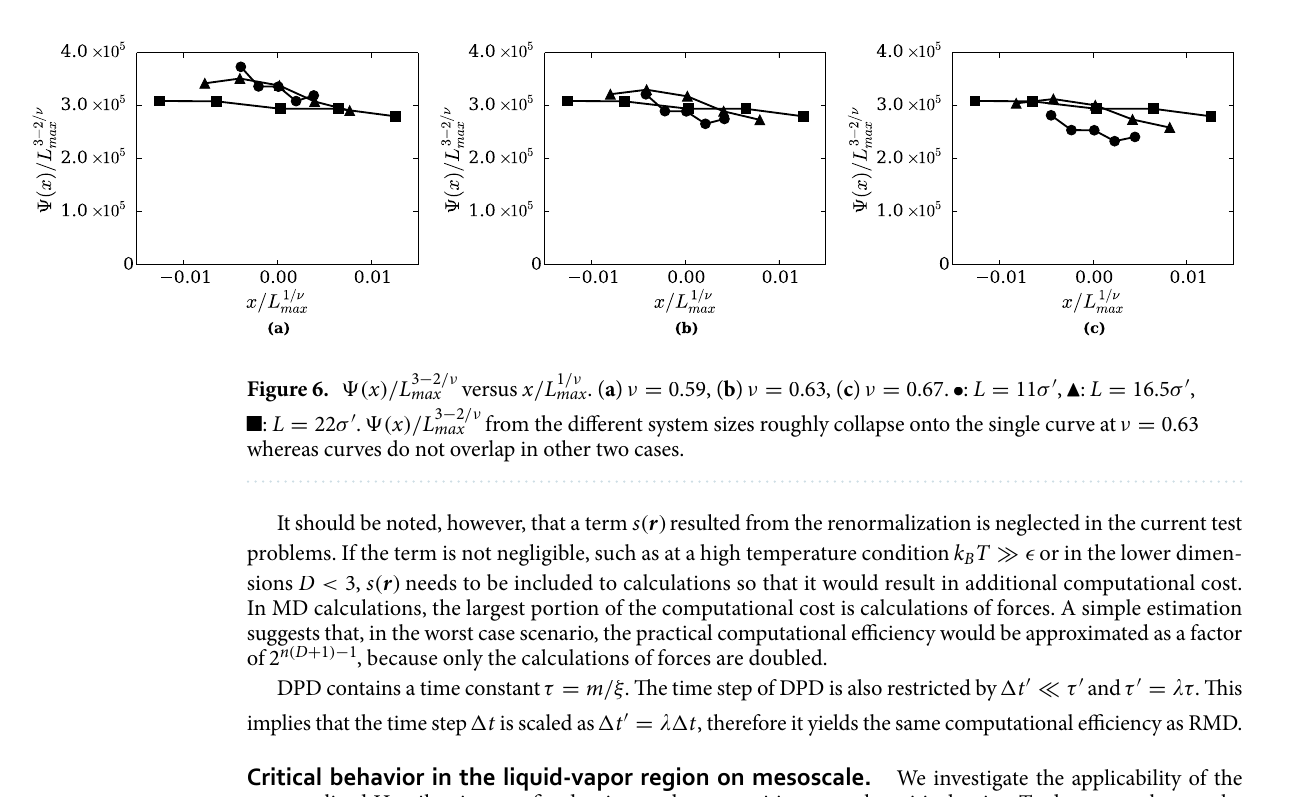
Figure 5. Consumption time of the RMD calculation versus the scaling factor. Black dots show the simulation results. Solid lines indicate the scale transformation rule t ′ c Collision of spheres. Both plots show that reduction of the consumption time follows the scale transformation rules.